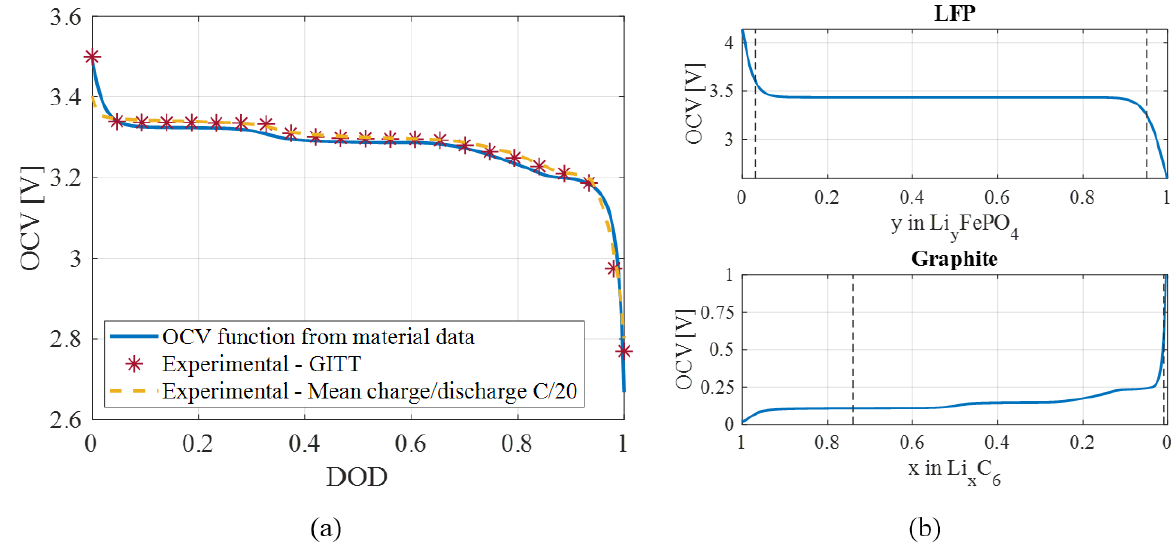
Figure 10. Identification of stoichiometric limits fitting the OCV function of single electrodes on the experimental OCV of the cell. OCV function and experimental OCV of the cell ( a ). The OCV function ( a ) is given by the difference between OCV functions of cathode and anode ( b ), whose analytical expressions are reported in Table